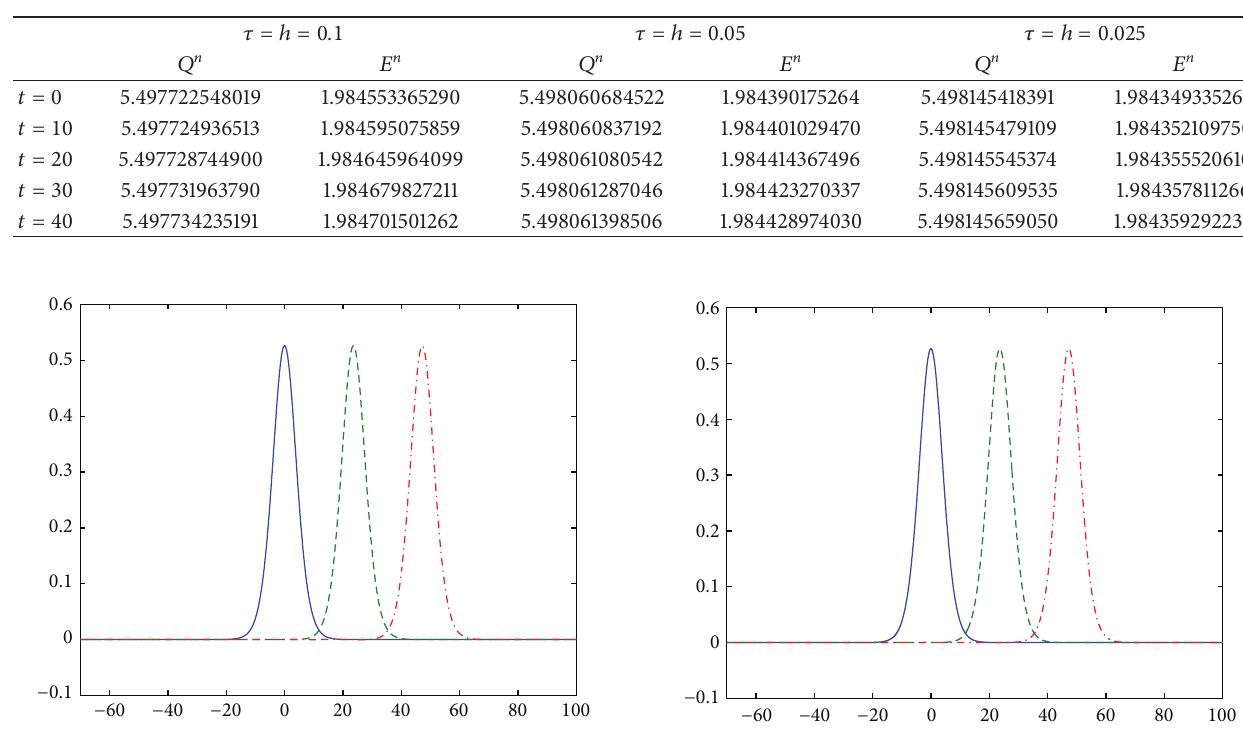
Table 3: Numerical simulations on the two conservation invariants 𝑄 𝑛 and 𝐸 𝑛 .